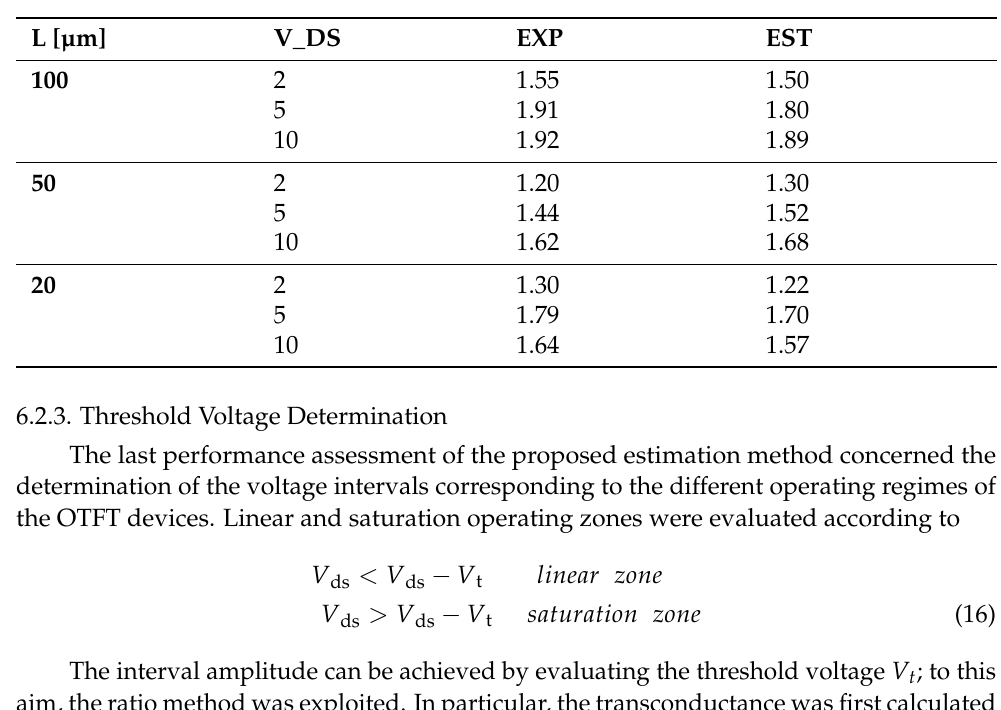
Table 3. Comparison between experimental and estimated data for CEA1298 P-type.